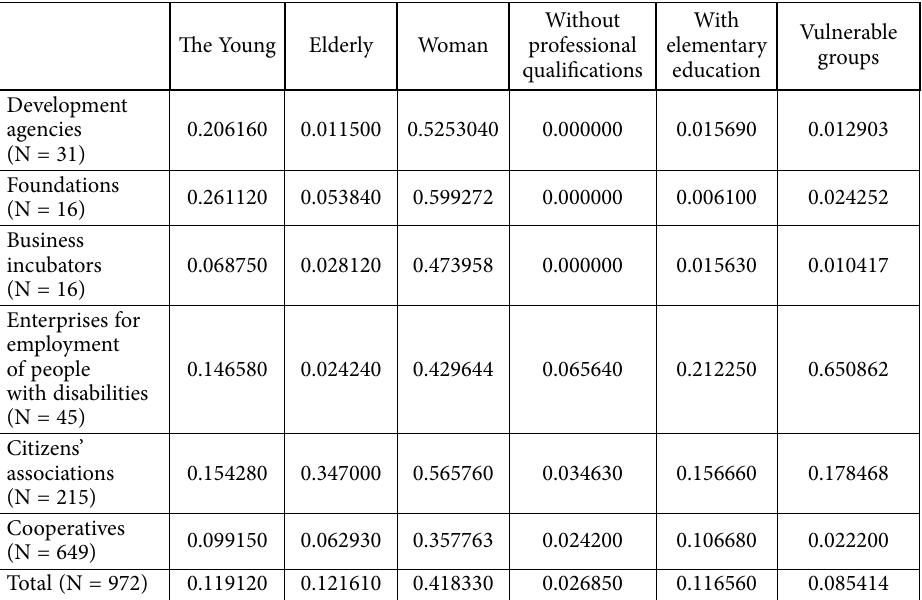
Without With Vulnerable professional elementary groups qualifications education